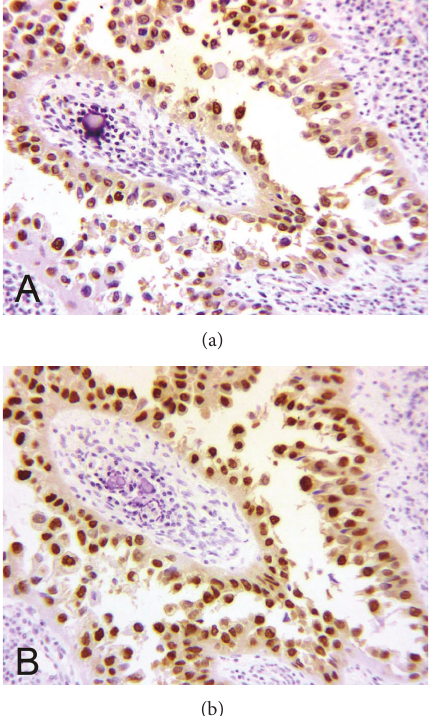
Figure 2: Immunohistochemical stains in clear cell adenocarci- noma.Diffusepositivenuclearstainingofhepatocytenuclearfactor- 1 beta (a) and PAX8